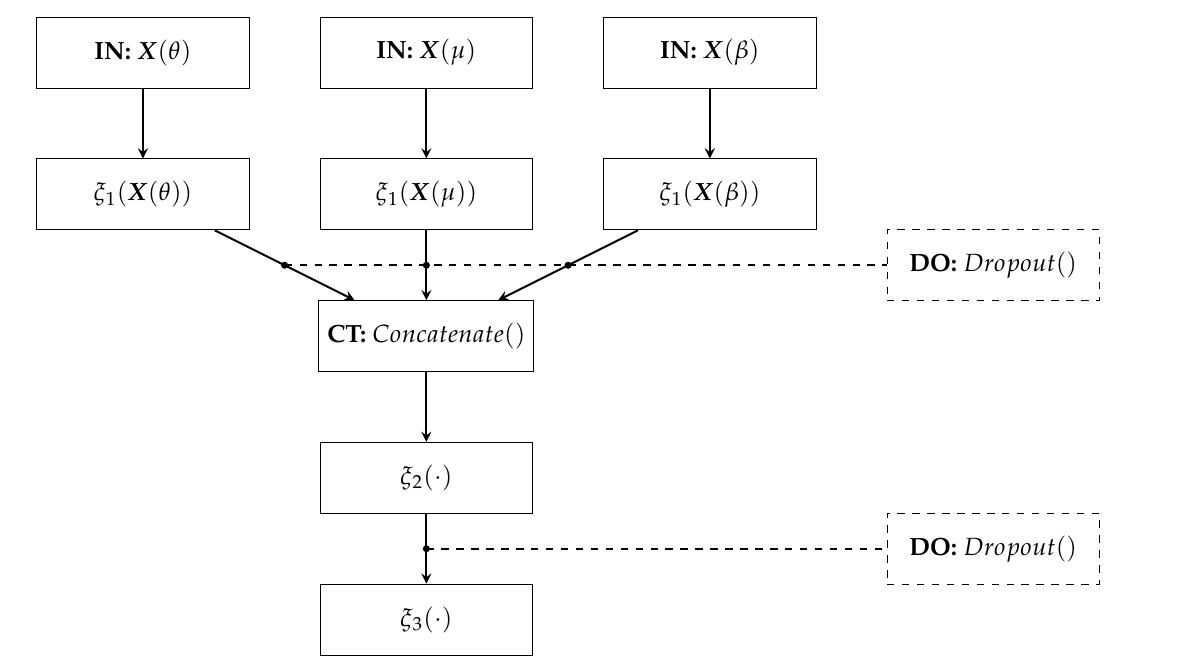
Figure 3. Deep Network Regressor’s